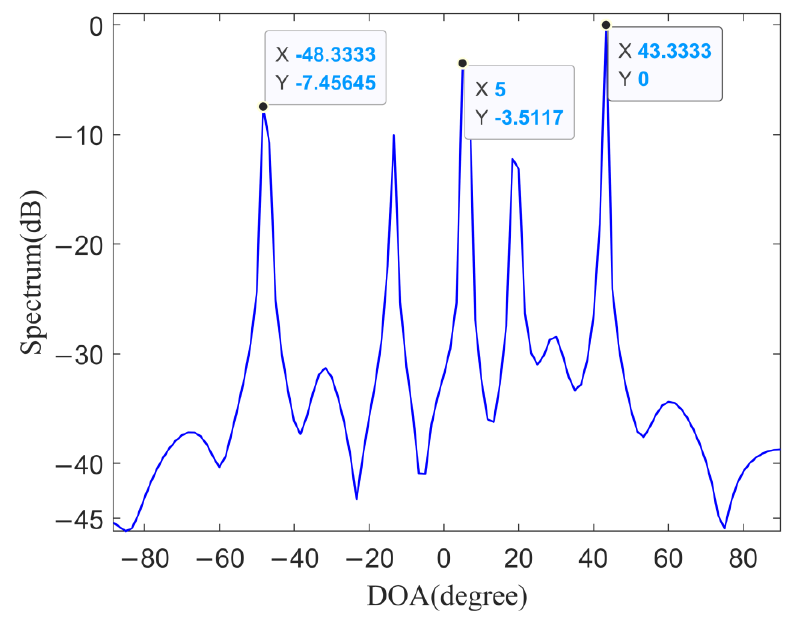
Figure 18. The second strong co-channel interference spatial spectrum. In Figure 18, five DOAs with strong co-channel interference are estimated by the proposed method and the interference energy in the directions of − 48.3 ◦ , 5 ◦ and 43.3 ◦ is the strongest. The RDCC is performed after the three strongest interferences are eliminated from the echo channel and Figure 19 shows the result of the RDCC.